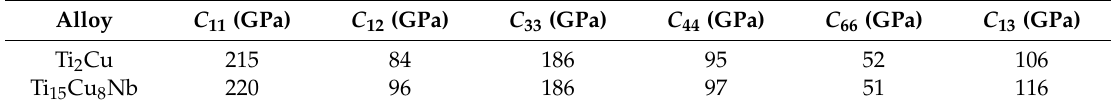
Table 2. Calculated elastic constants C ij of the Ti 2 Cu and Ti 15 Cu 8 Nb intermetallics.